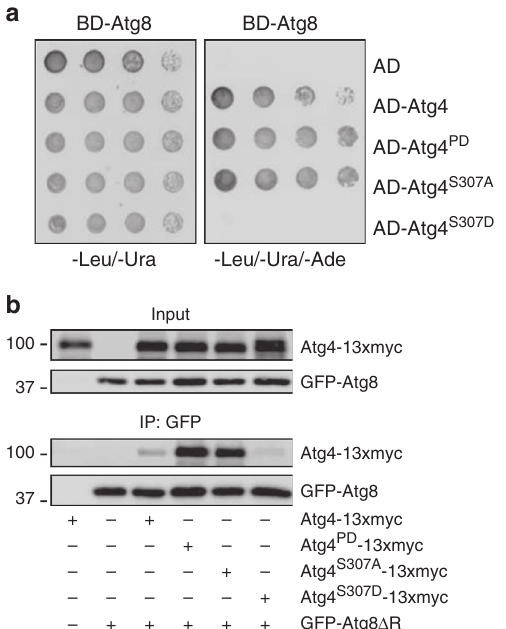
Fig. 3 The phosphorylation state of S307 modulates Atg4 interaction with Atg8. a Atg4 and Atg8 were fused to the activation domain (AD) and/or the DNA-binding domain (BD) of Gal4, respectively. Plasmids were transformed into the PJ69-4A strain and colonies were spotted on medium lacking leucine and uracil (control plate) or leucine, uracil, and adenine (test plate). Growth on the test plate indicates interaction. The control was cells expressing BD-Atg8 alone. b Phosphorylation of S307 blocks the interaction of Atg4 with conjugated Atg8. The atg4 Δ (SAY084) mutant transformed with WT Atg4-13xmyc and the atg4 Δ strain with stably integrated pCuGFPAtg8 Δ R(305) (JSY151) carrying a plasmid expressing the 13xmyc-tagged WT or the indicated Atg4 variants, were exponentially grown and nitrogen starved in SD-N for 1 h. Cell lysates were subjected to pull-down experiments using GFP-trap sepharose beads. Isolated proteins, 4% of cell lysate (input) or 100% of the pull-down material (IP), were resolved by SDS-PAGE and analyzed by western blot using anti-myc